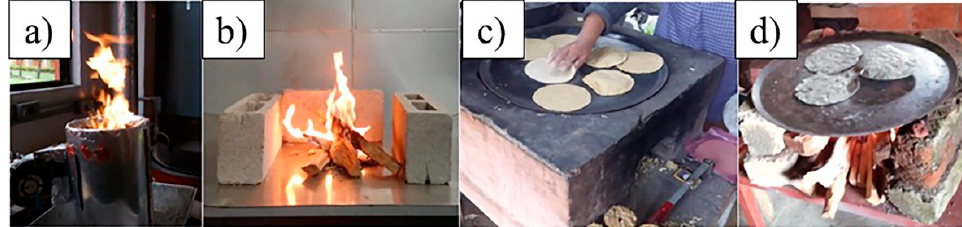
Figure 3. ( a ) Forced draft gasifier/briquettes, ( b ) Three-stone fire/fuelwood, ( c ) Patsari cookstove/briquettes, ( d ) “U” type/fuelwood.